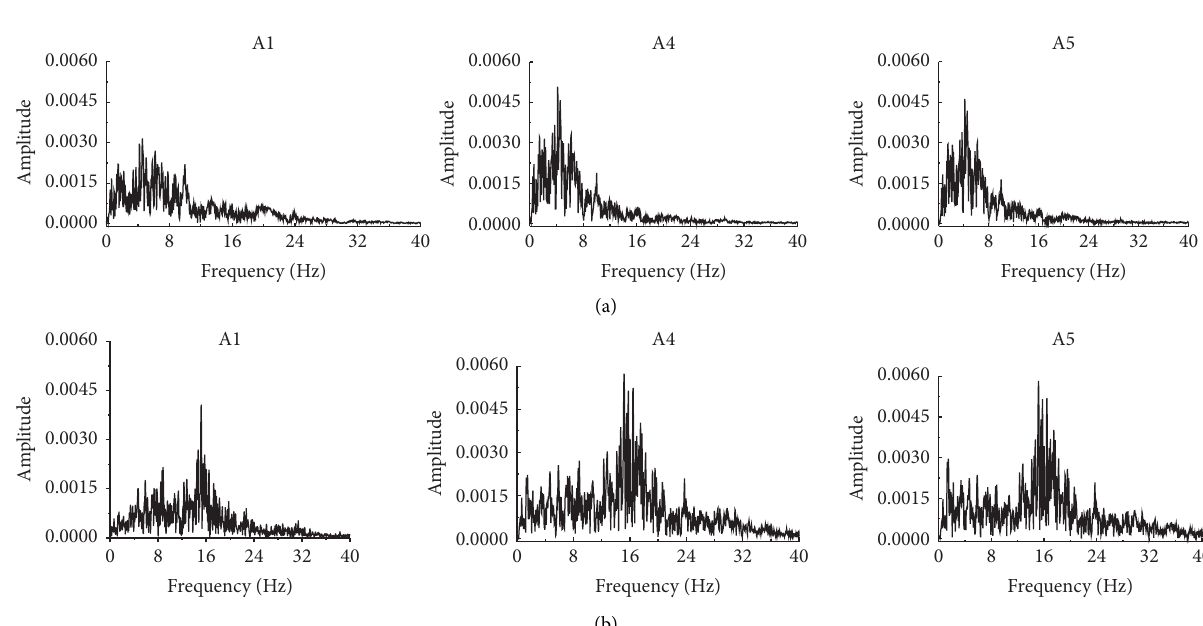
Figure 16: Acceleration Fourier spectrum of test 2 and test 5 soil layers under El-2 input. (a) Test 2. (b) Test